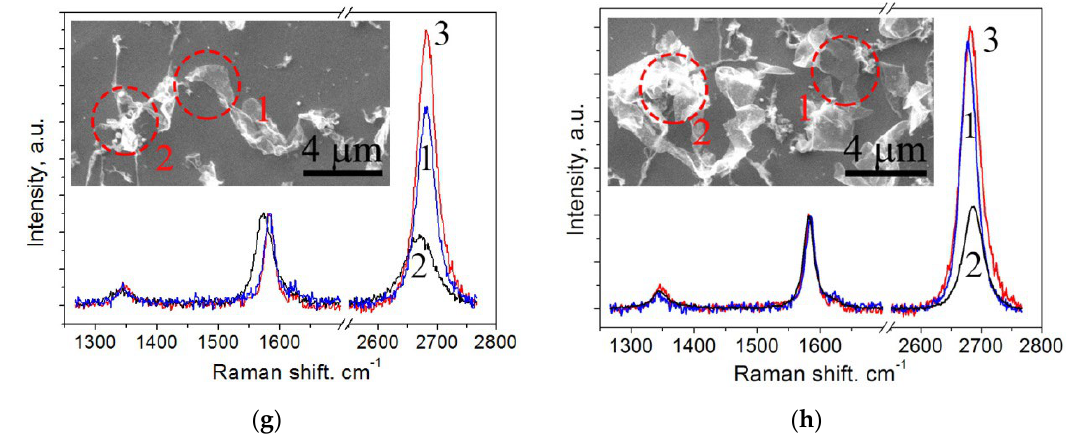
Figure 4. The side-view SEM images of characteristic-pattern regions and single elements with their Raman spectra after single ( a , c , e , g ) and triple ( b , d , f , h ) laser exposure. Blue curves in the Raman spectra correspond to the transferred flat graphene fragments (area 1 in the inset), black curves to the transferred crumpled graphene (area 2 in the inset), and red curves to the original graphene before transfer (3).